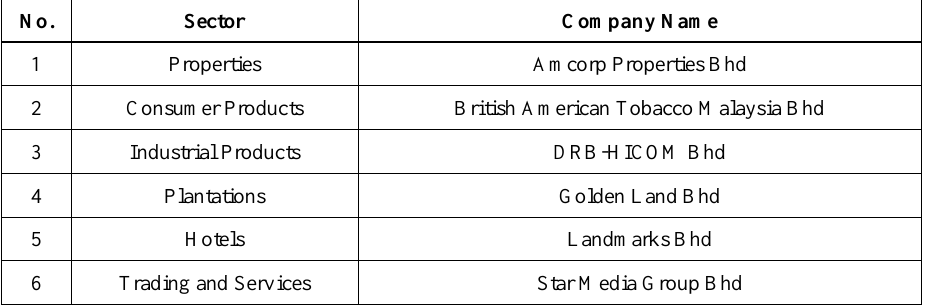
Table 2. Six selected companies in Malaysian stock